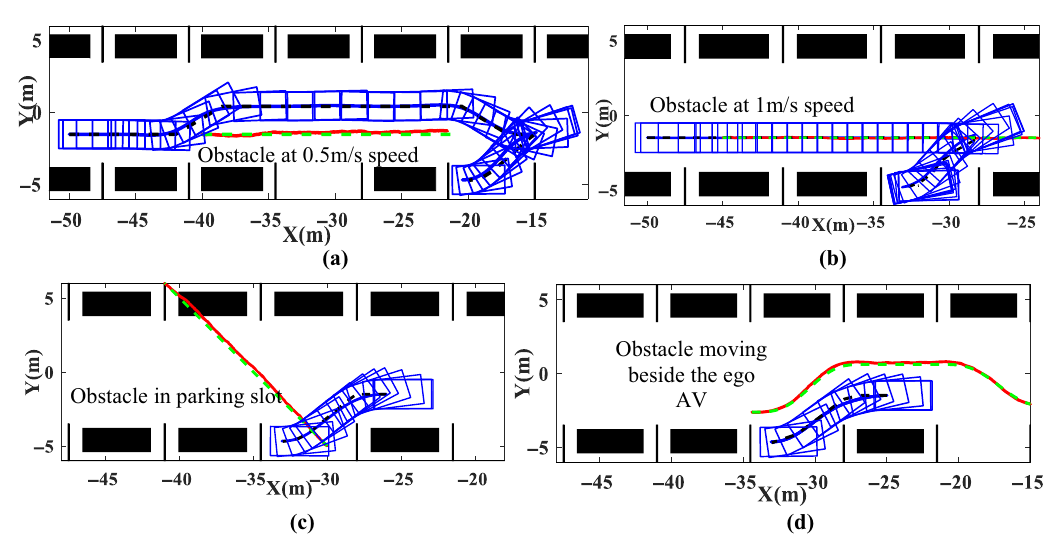
Figure 8 Paths planned by our